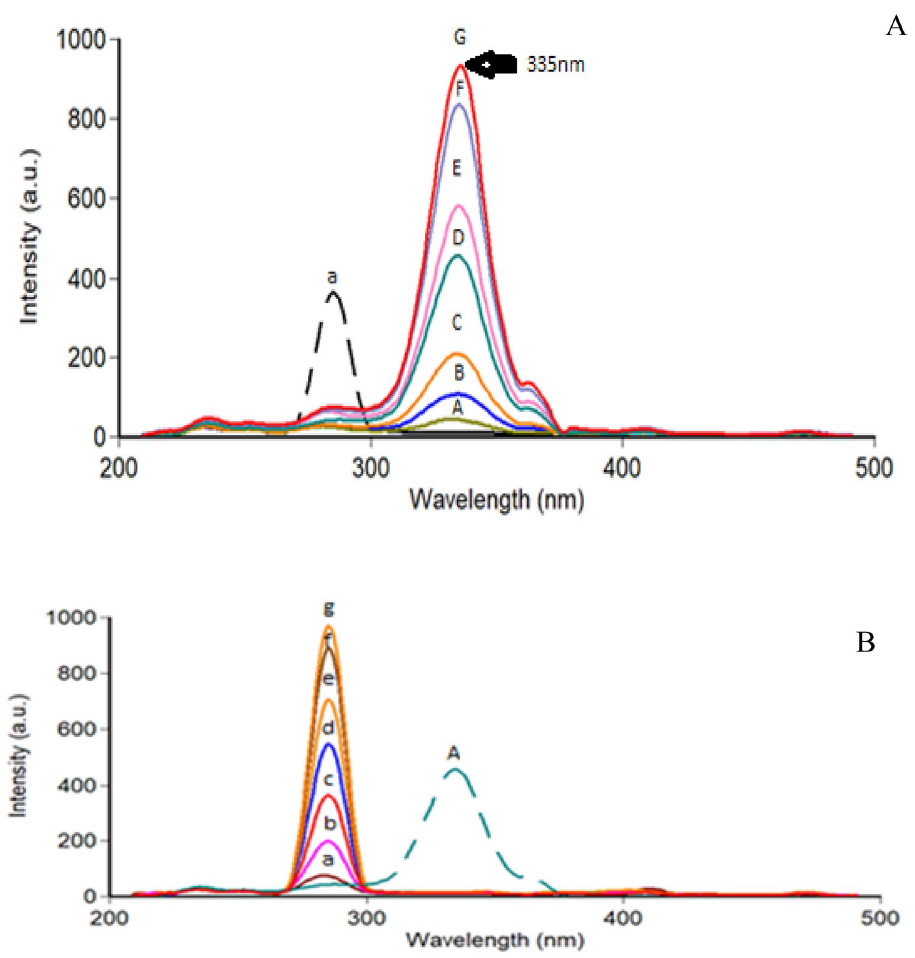
Figure 4. ( A ): Synchronous fluorescence spectra of different concentrations of TEL with a constant concentration of NEB. Where: (A -F): TEL at concentrations of (50.0, 100.0, 200.0, 400.0, 500.0,700.0 and 800.0 ng /mL).(a): NEB concentration (200.0 ng /mL). ( B ): Synchronous fluorescence spectra of different concentrations of NEB with a constant concentration of TEL. Where: (A -F): NEB at concentrations of (30.0, 100.0, 200.0, 300, 400.0,500.0 and 550.0 ng /mL). (a): TEL concentration (400.0 ng